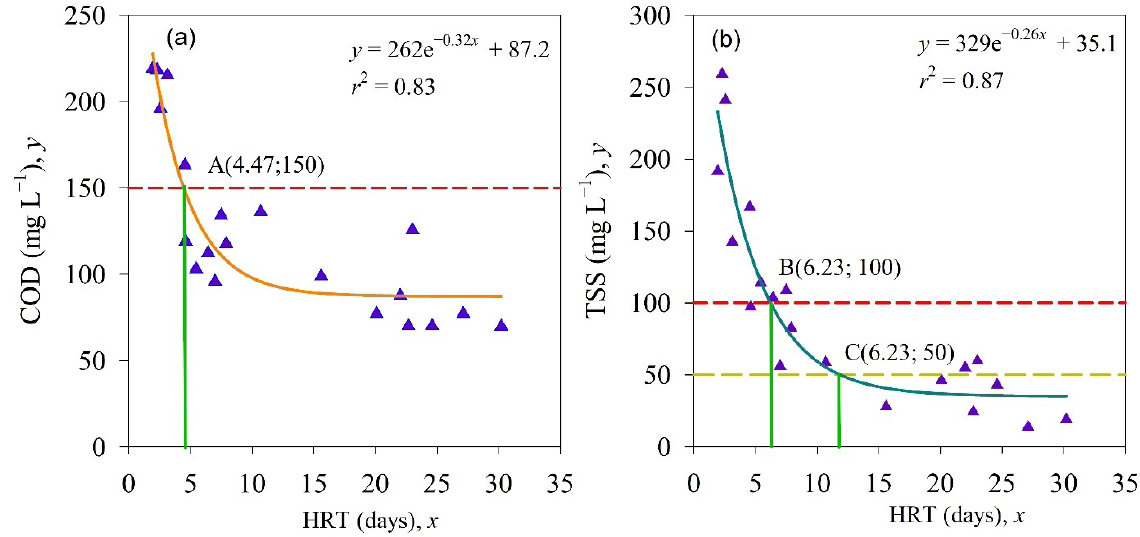
Figure 2. Relationship between COD and HRT (orange line) ( a ), and TSS and HRT (blue line) ( b ). The non-linear regression was done at a confidence interval of 95%. Red-dotted lines and the yellow line show the allowable limit of pollutant concentration in shrimp wastewater before releasing it to the receiving environment (QCVN 02-19:2014/BNNPTNT) and BAP, respectively.